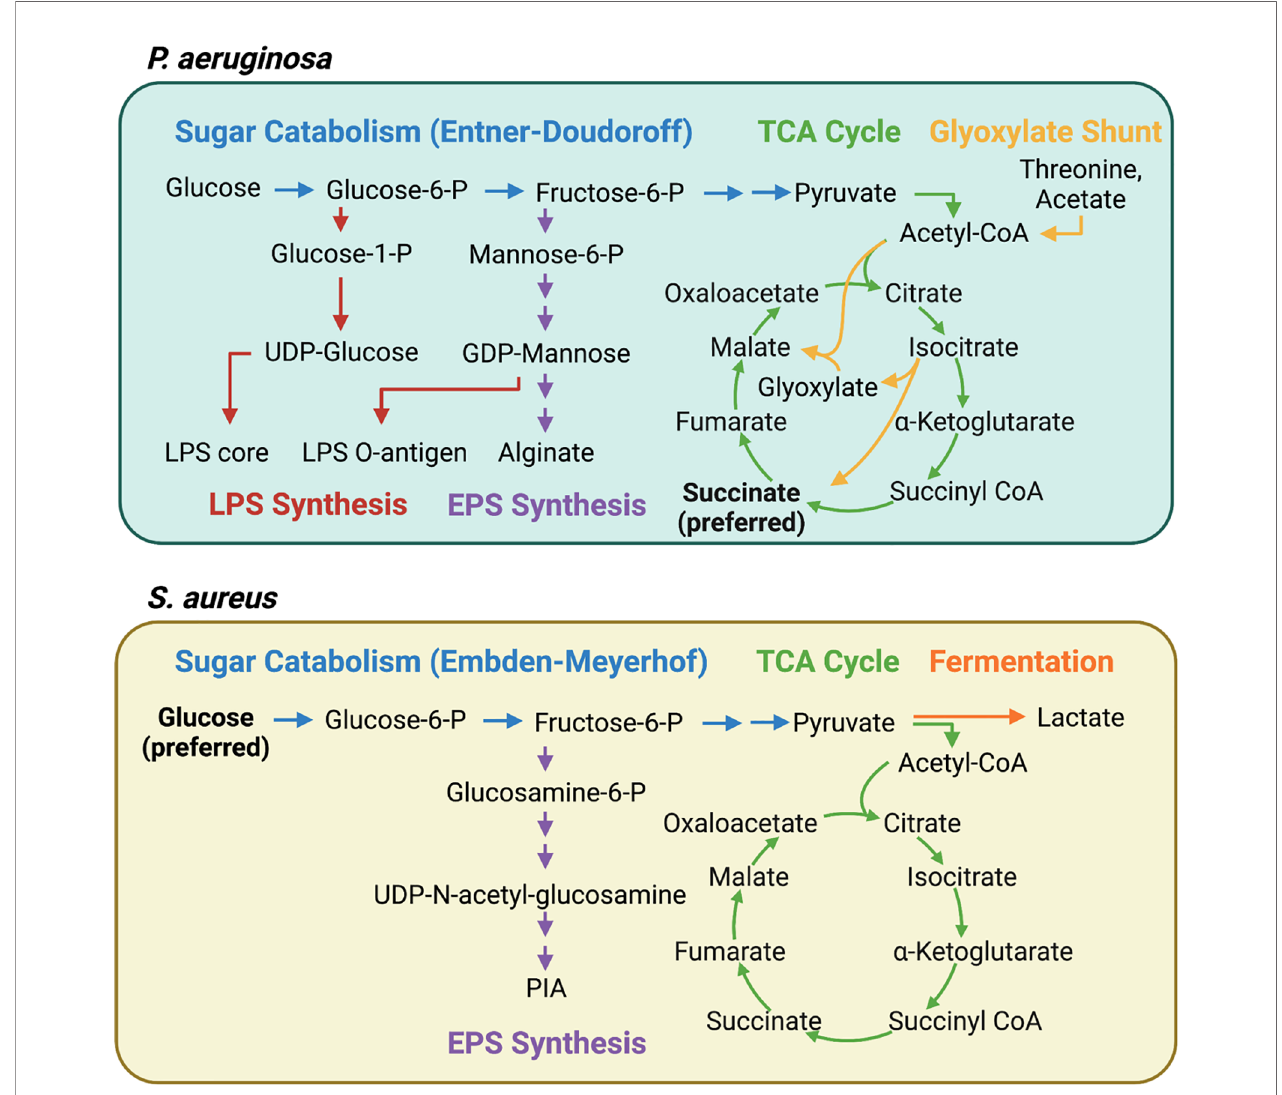
FIGURE 2 | Interconnected pathways contributing to central carbon metabolism, LPS, and EPS synthesis in P. aeruginosa and S. aureus . P. aeruginosa and S. aureus have distinct carbon preferences and metabolic pathways that contribute to pathogenesis. Carbon catabolite repression (CCR) ensures that P. aeruginosa consumes succinate until it is depleted whereas S. aureus preferentially consumes glucose. The continuous consumption of succinate by P. aeruginosa generates endogenous bacterial reactive oxygen species (ROS) via increased aerobic respiration. P. aeruginosa adapts by bypassing OXPHOS and upregulating the glyoxylate shunt and the Entner-Doudoroff pathways, resulting in increased extracellular polysaccharide (EPS) synthesis. S. aureus , meanwhile, is highly dependent on glycolysis and fermentative metabolism for survival during infection. When glycolysis is interrupted, as it is in itaconate-rich environments, carbon is shunted into EPS